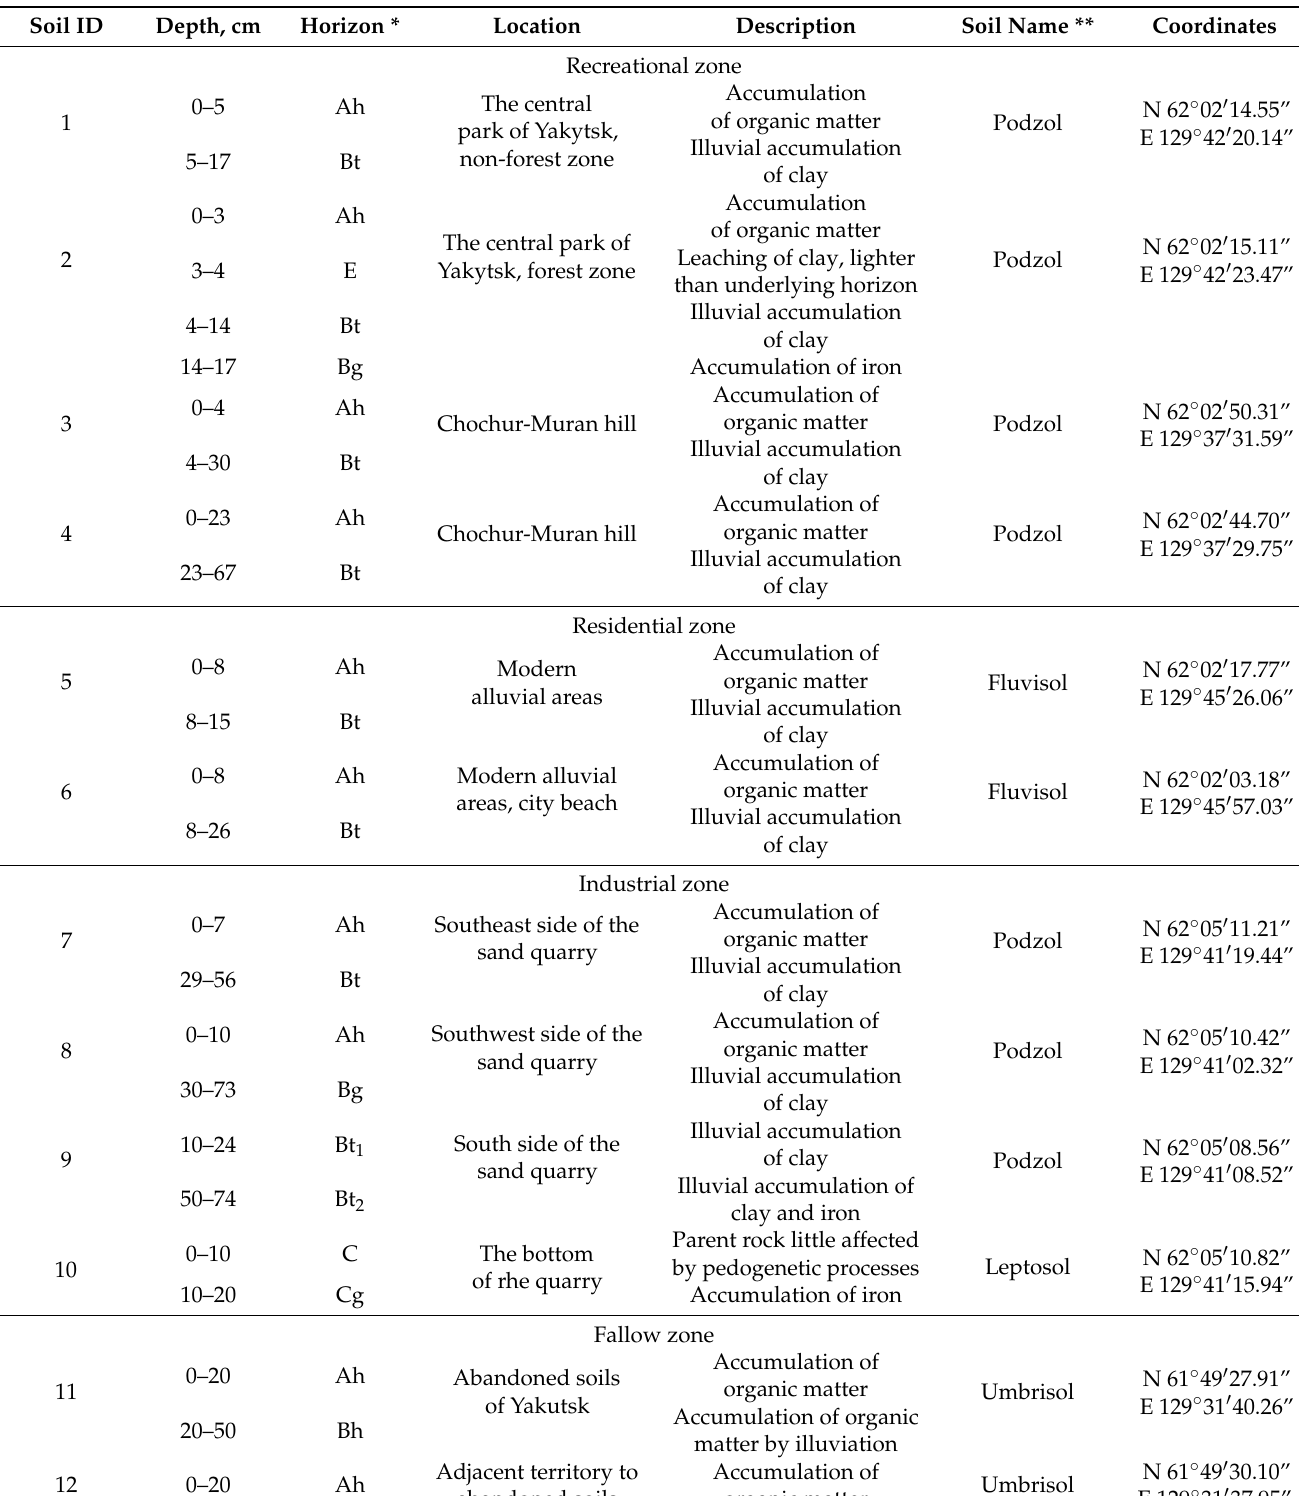
Table 1. Description of study soils. Yakutsk